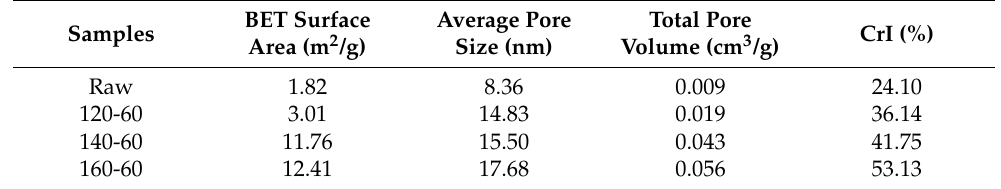
Table 2. BET surface area, average pore size, pore volume and crystallinity (CrI) of solid residue. Samples